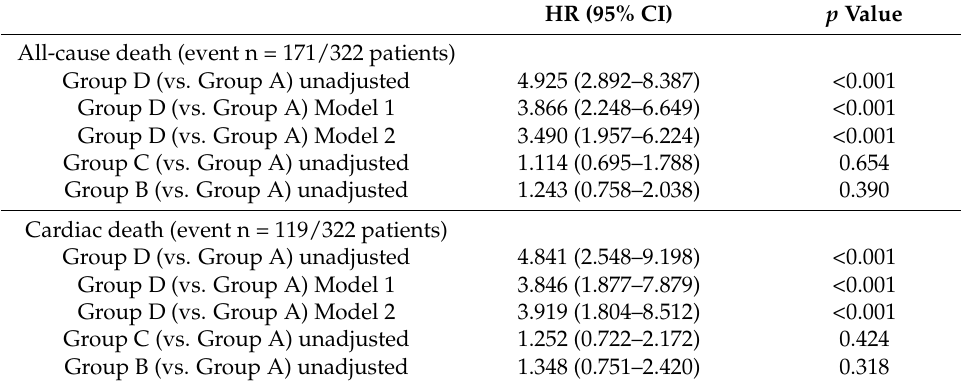
Figure 2. Kaplan–Meier analysis for all-cause death and cardiac death when heart failure patients are sorted into four groups according to blood levels of chloride. Table 2. Cox proportional hazard analysis after 2nd